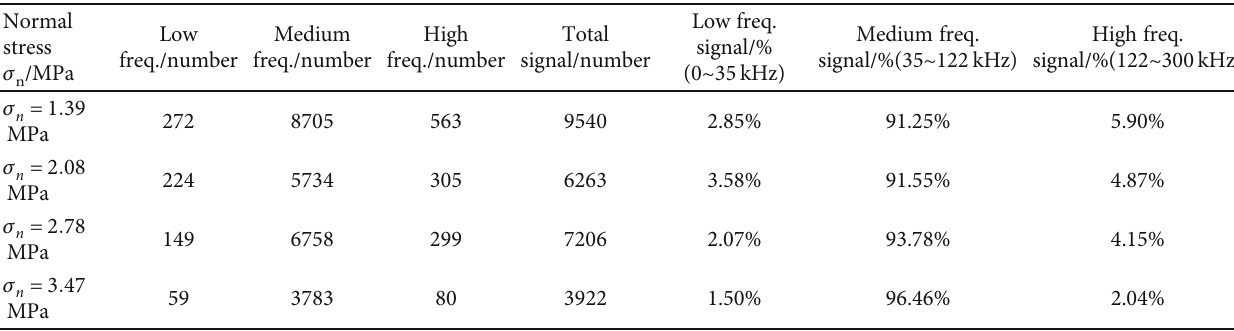
Table 4: Percentage of AE signals of low, medium, and high frequencies in the rock shearing process under four normal stresses. Normal Low stress σ /MPa n